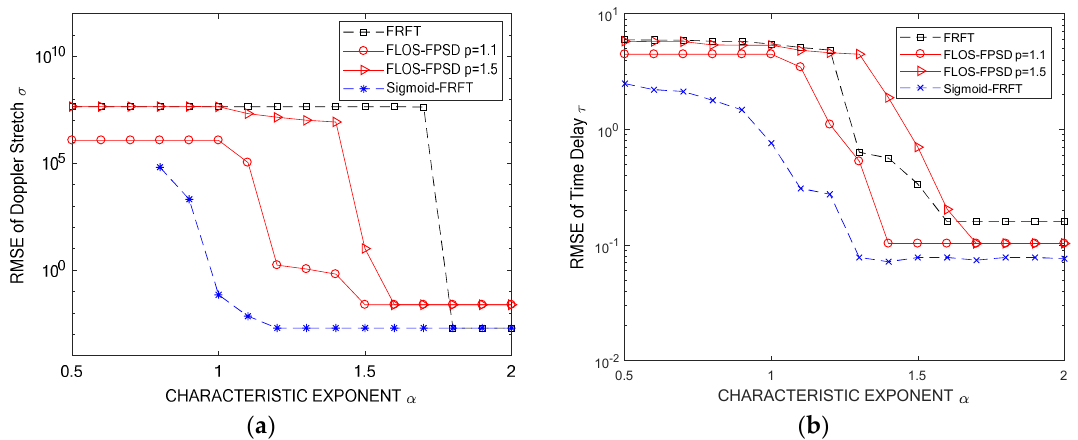
Figure 5. RMSE of parameters versus Characteristic Exponent α . ( a ) RMSE of Doppler stretch; ( b ) RMSE of time delay.